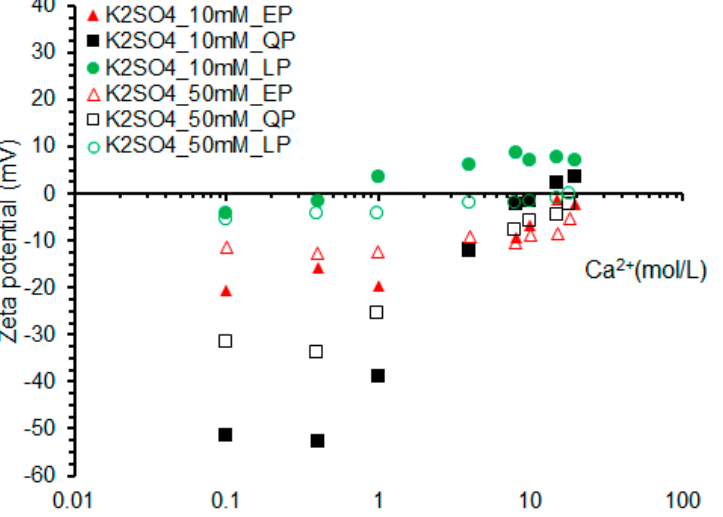
Figure 10. Zeta potentials of EP, QP and LP with Ca 2+ concentration in 10 mmol/L and 50 mmol/L K 2 SO 4 solutions.